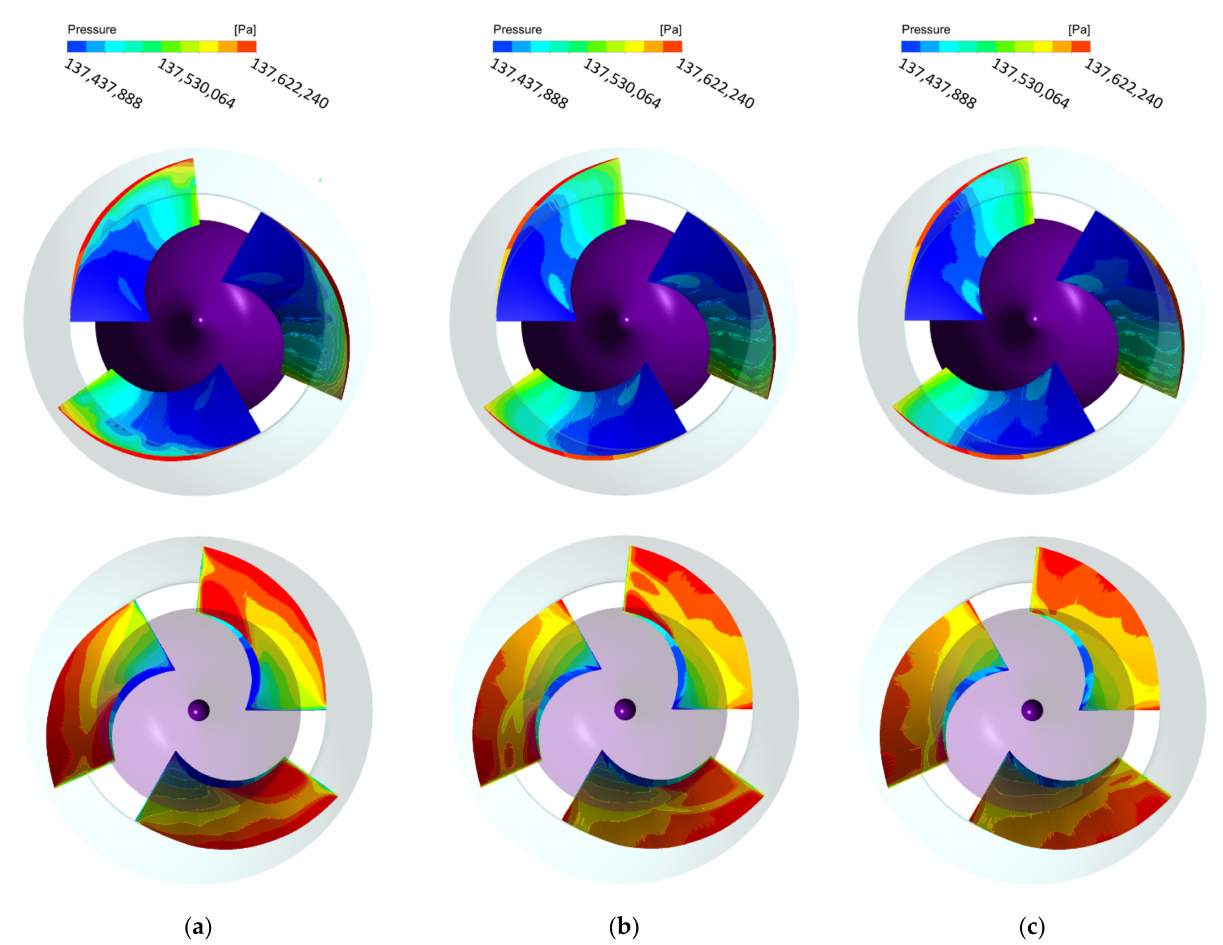
Figure 9. Contours of static pressure on the runner blade’s suction (up) and pressure (down) sides under different flow conditions ( a ) 0.41 Q BEP , ( b ) 0.65 Q BEP , ( c ) 0.83 Q BEP